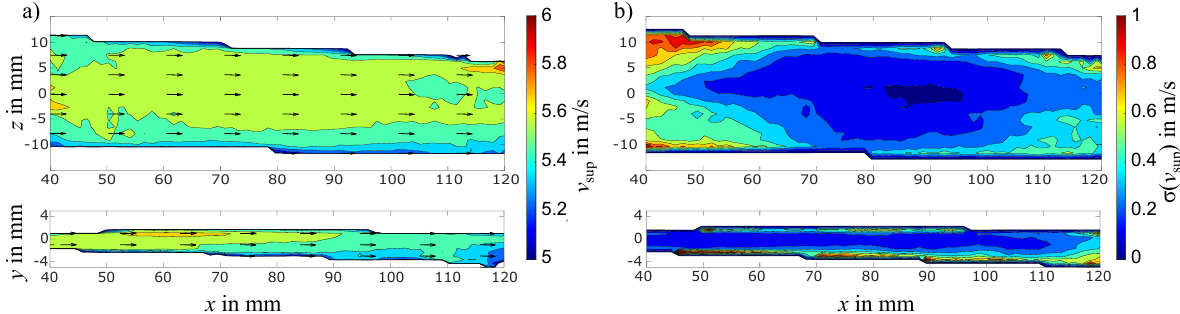
Figure 6. Calculated velocity field for the top view and the side view ( a ) and the corresponding standard deviation ( b ) for a volume flow of 14.9L/min.